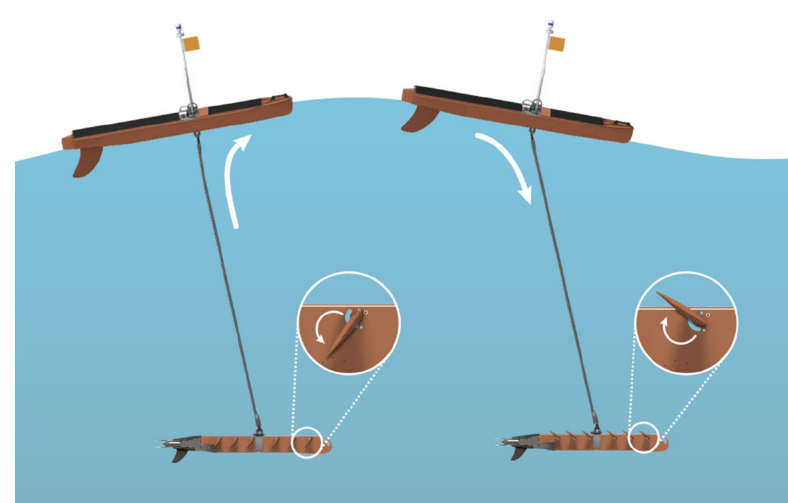
Figure 1. The working principle of the wave glider.